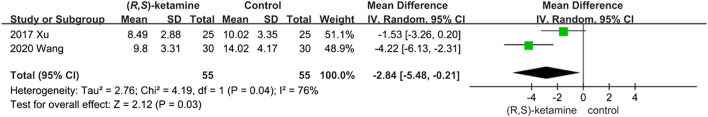
Extubation time forest plot.